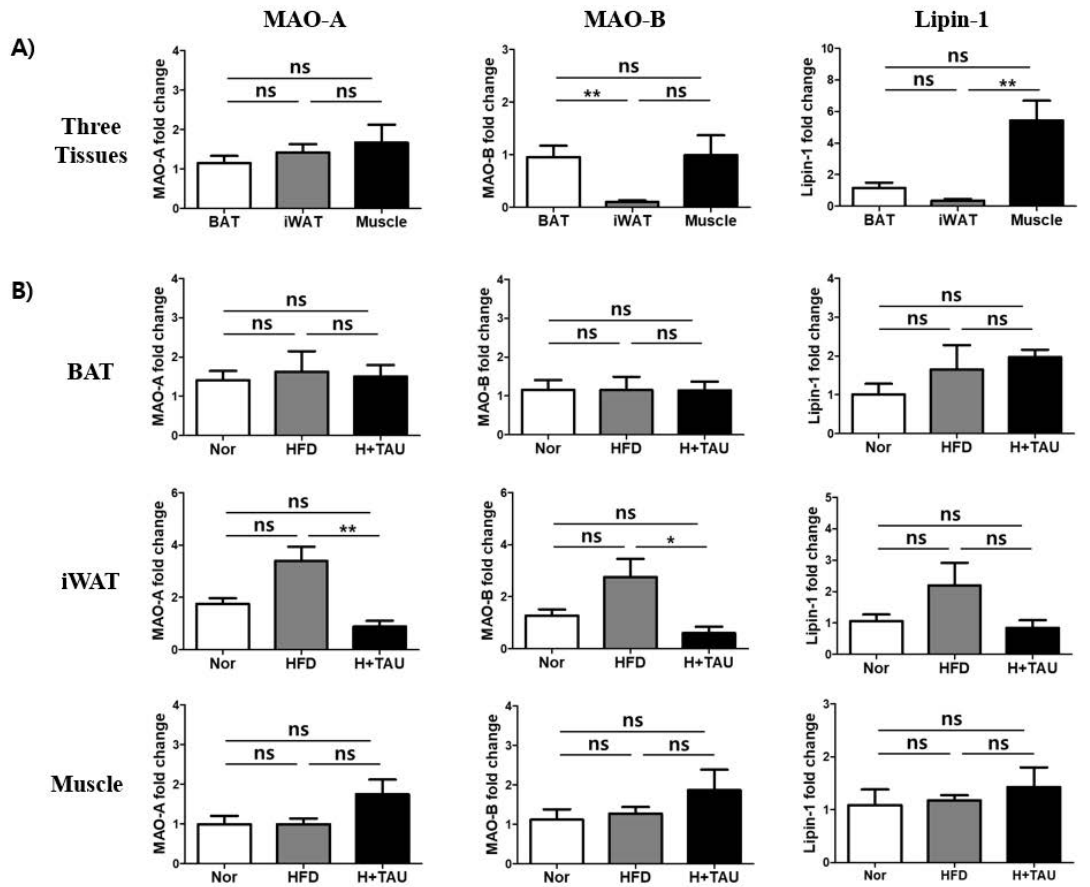
Figure 4. E ff ects of taurine on the transcriptional expression of monoamine oxidase (MAO) and lipin-1 in tissues. ( A ) The relative basal mRNA expression levels of MAO-A, MAO-B, and lipin-1 were compared in the three tissues of the normal diet (N) group. ( B ) The mRNA expression levels were compared to evaluate the e ff ect of HFD and / or taurine supplementation on each tissue of the three groups: N normal diet group ( n = 5), HFD high-fat diet group ( n = 5), and H + Tau HFD + taurine (2% in drinking water) group ( n = 5). Di ff erences between the three groups were analyzed using the nonparametric Kruskal–Wallis test as described in Figure 2. Di ff erences were considered statistically significant at p < 0.05. ** p < 0.01; * p < 0.05; ns not